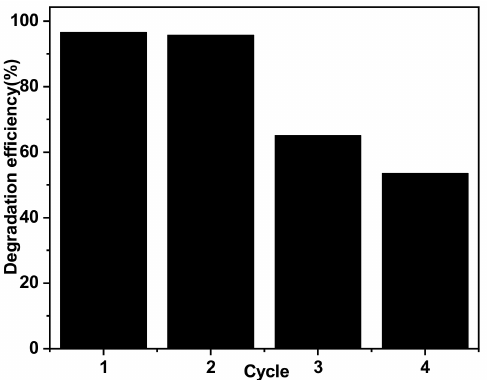
Figure 12. Reusability study of P-AgC 13%) (volume of MO: 0.3 L, number of the film: 2 films, MO concentration: 10